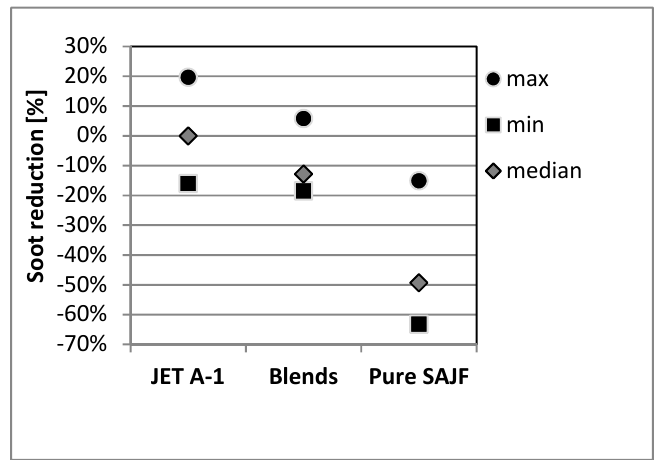
Figure 15. Comparison between soot reduction potential of crude-oil based Jet A-1 and alternative jet fuel blends at an academic reference setup.